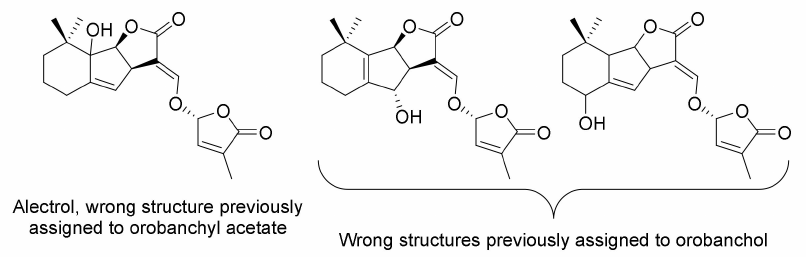
Figure 3. Structure of alectrol, and two wrong structures previously assigned to